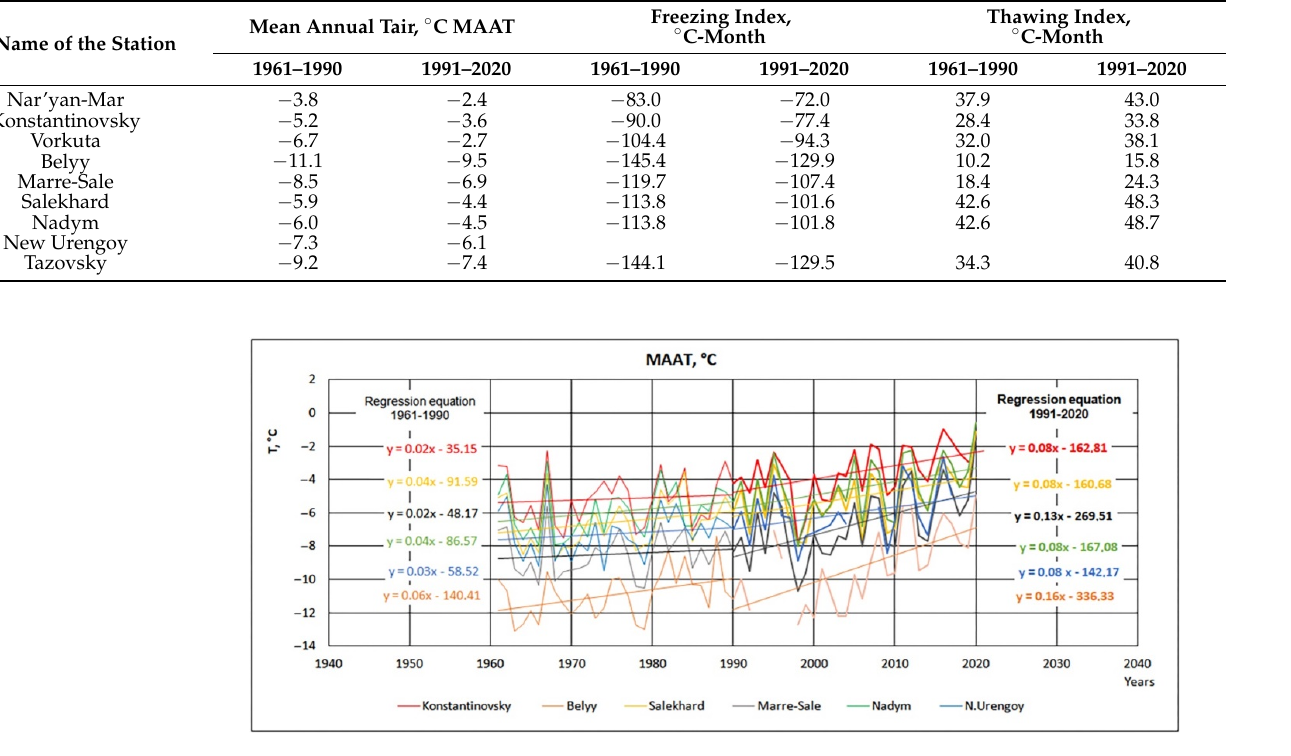
Figure 2. Changes in mean annual air temperature at weather stations in the western sector of the Russian Arctic.